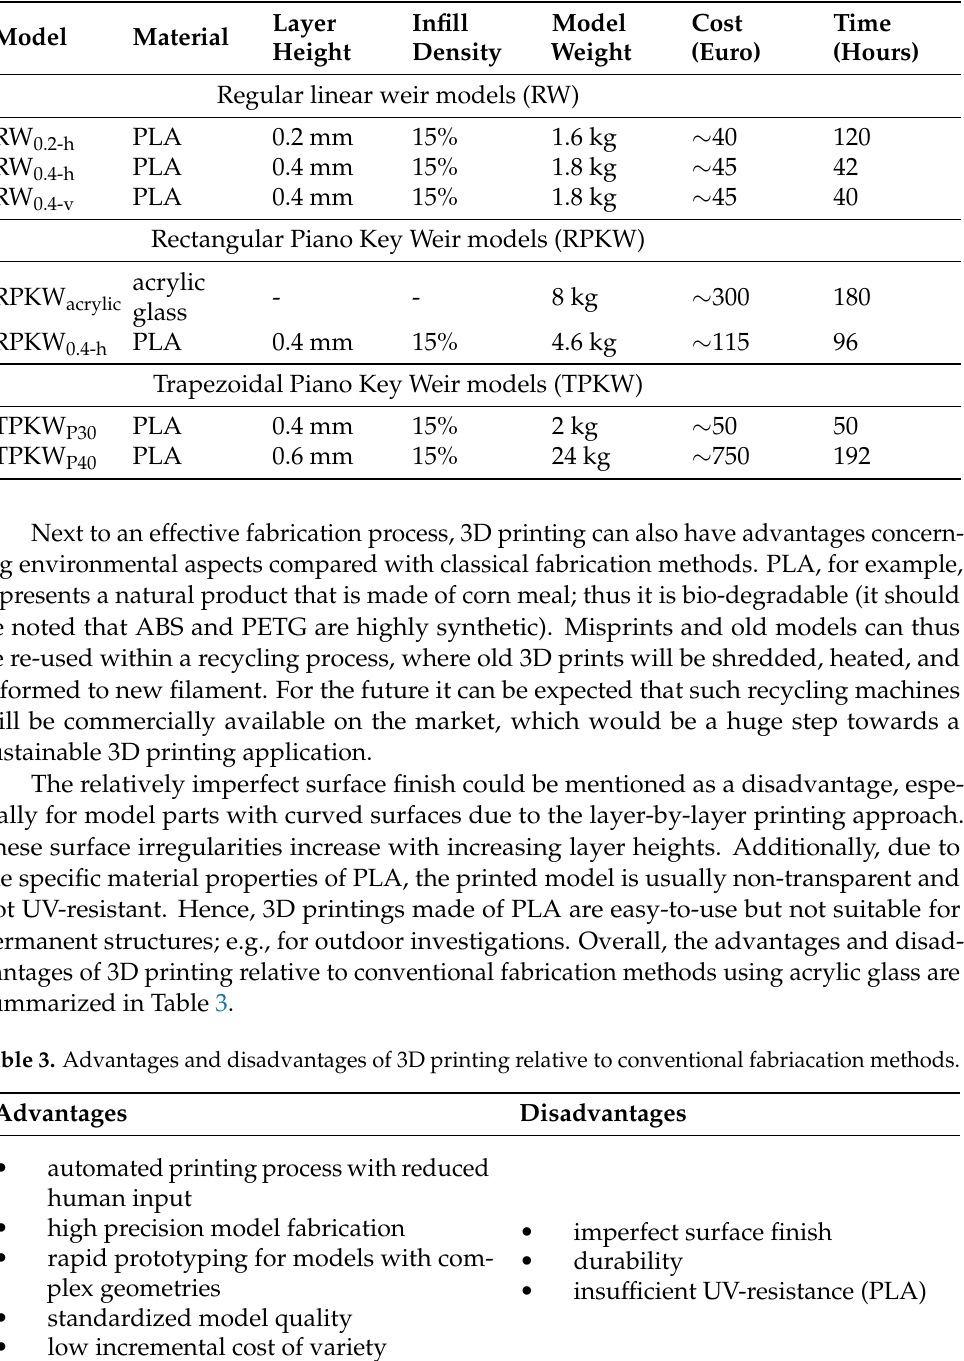
Table 2. Comparison of material costs and fabrication times.